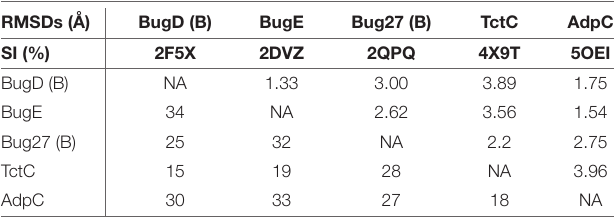
TABLE 2 | Comparison between the TctC homologs structures available in the PDB. RMSDs (Å)